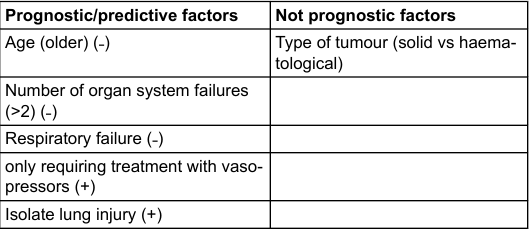
Table 2: Prognostic factors for mortality of cancer patients in the ICU. Prognostic/predictive